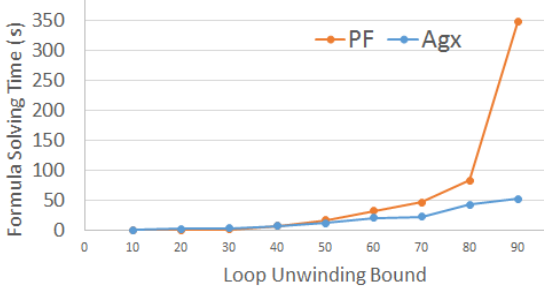
Figure 10. Formula solving time with increasing loop unwinding